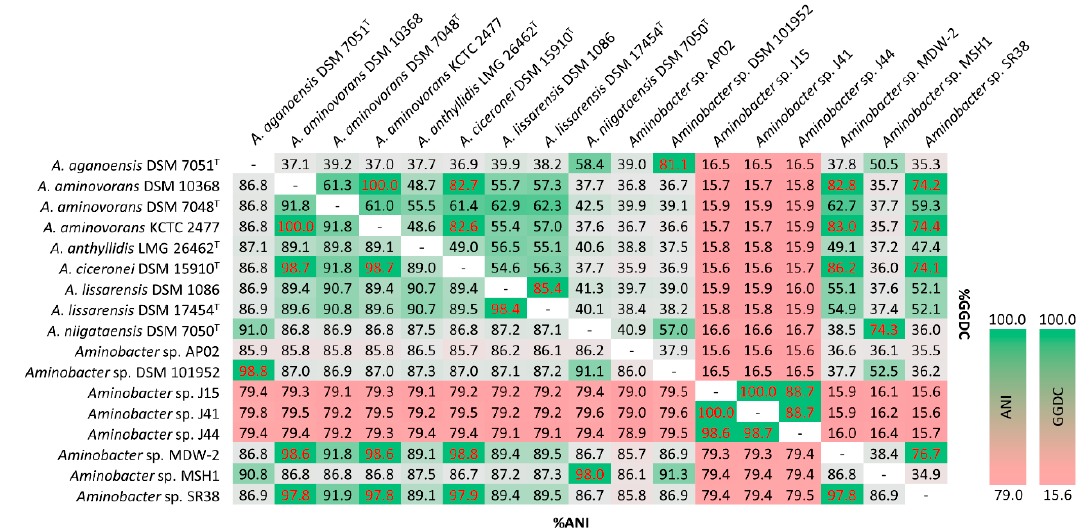
Figure 3. Results of ANI calculation using FastANI and dDDH for the available genomes of Aminobacter strains. Text in red indicates ANI and GGDC values exceeding the threshold for species delineation (>96% for ANI and >70% for GGDC).